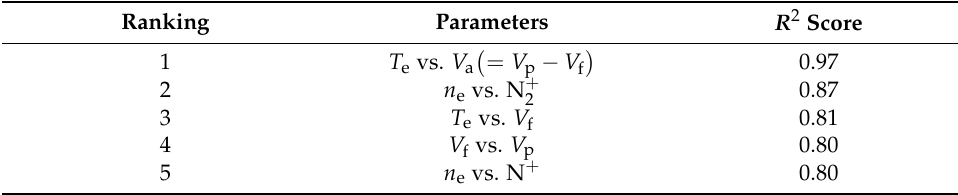
Figure 4. Regression results between the plasma parameters. Table 1. Regression results between the plasma parameters for an R 2 >